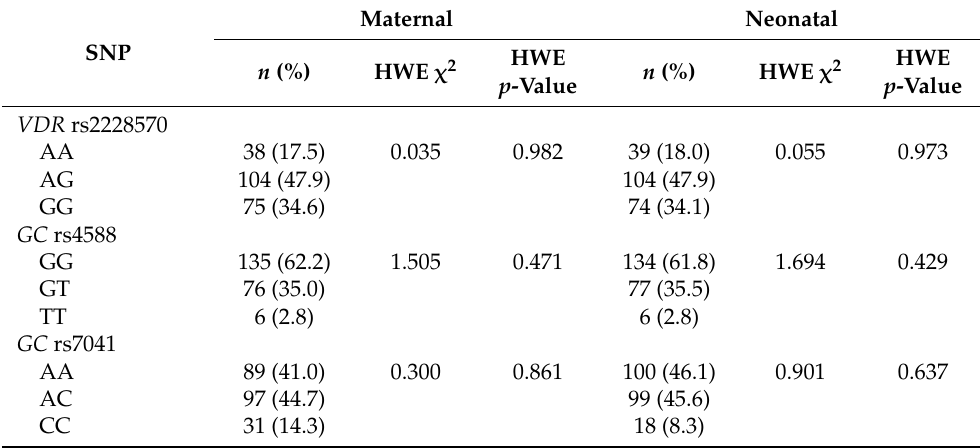
Table 2. VDR and GC single nucleotide polymorphism genotype distributions of mothers and